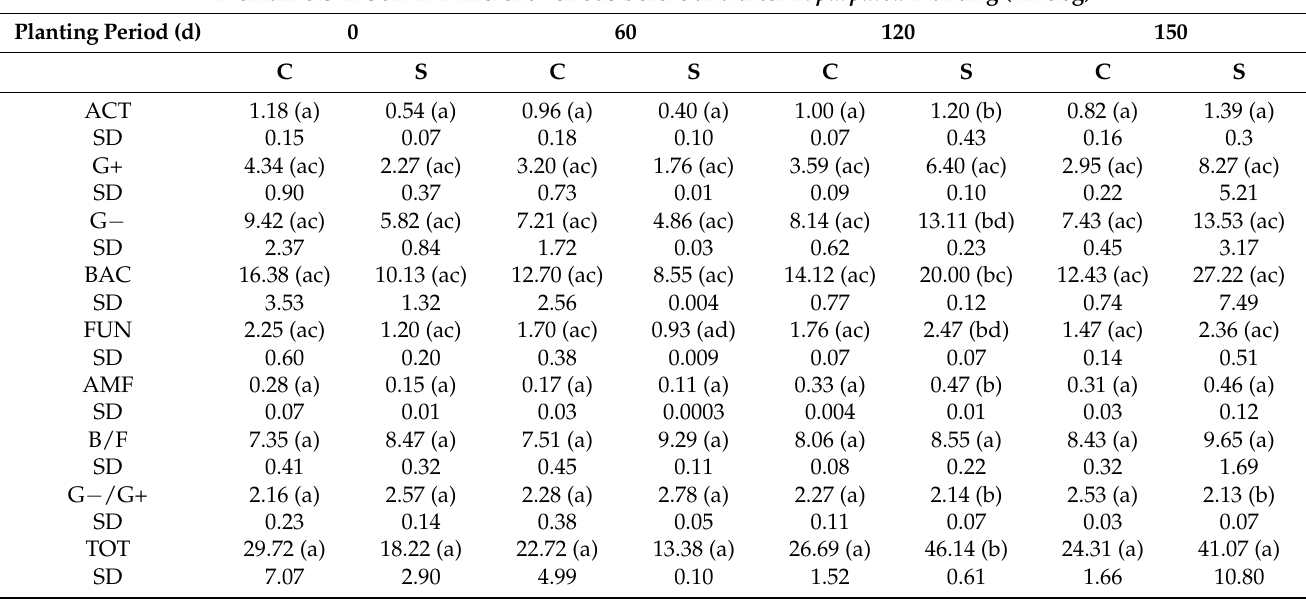
Table 1. Biomarker concentrations in soil at 0, 60, 120, and 150 days before and after planting E. purpurea